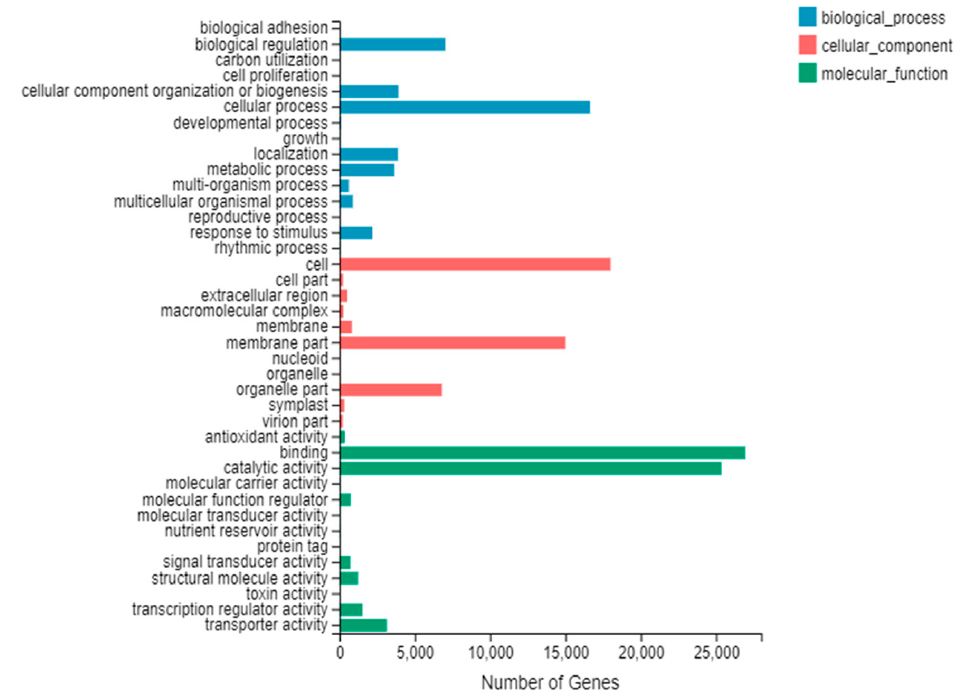
Figure 3. Histogram presentation of Gene Ontology classifications.